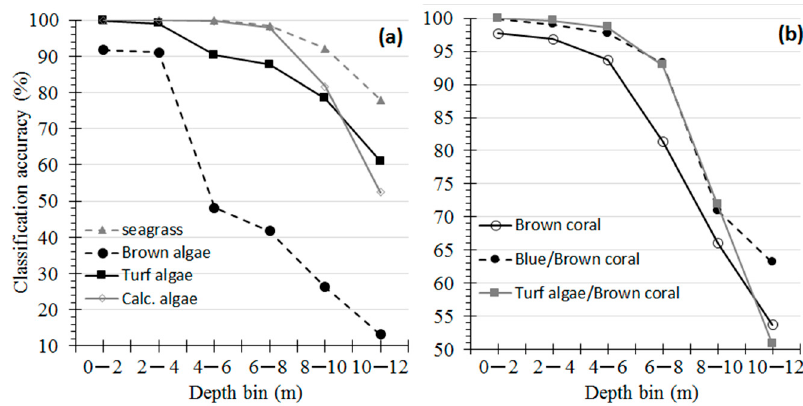
Figure 4. Classification accuracy of the five depth BSP-classifiers for ( a ) seagrass and algae classes, and; ( b ) the coral classes. Table 4. The overall classification accuracy of: ( a ) 0–2 m; ( b ) 4–6 m, and; ( c ) 8–10 m depth BSP-classifiers when θ s , Y , S dg are varied for the modeled R rs . * shows the reference accuracy generated with parameters ( θ s = 30 ◦ , Y = 0.5 and S dg = 0.018 nm − 1 ) used to train the classifiers. † shows the parameter that produced the largest decrease in classification